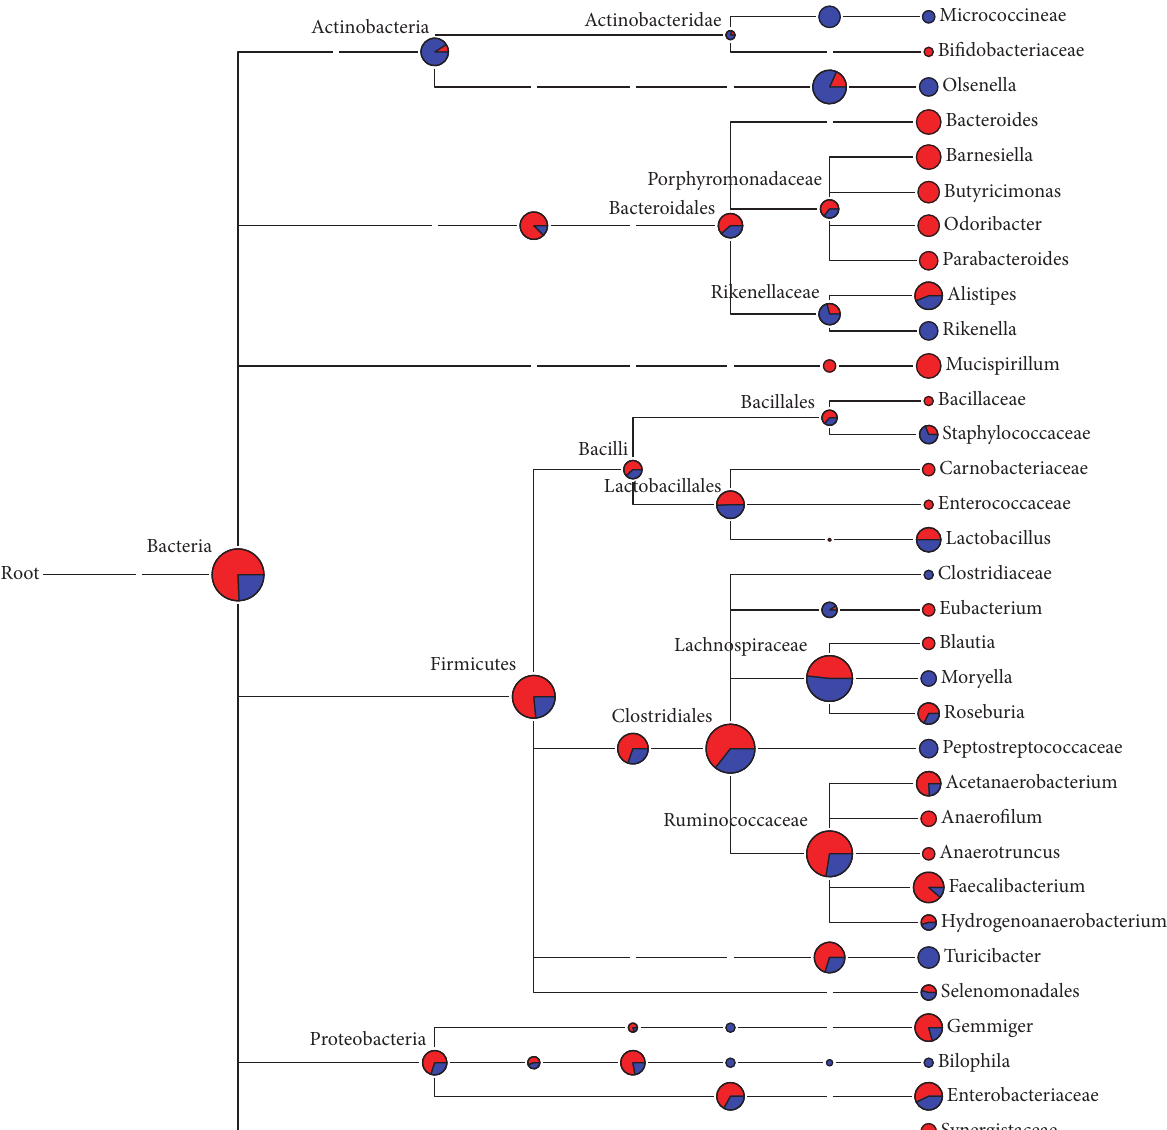
Figure 5: Comparison of the diversity of cecal content bacteriomes between broiler chickens and turkey. Only the genera represented by ≥ 5 OTUs each were shown, and the size of each node reflects the total number of OTUs from the four microbiomes. The proportion of each microbiome is distinguished by color: red, chicken; blue,